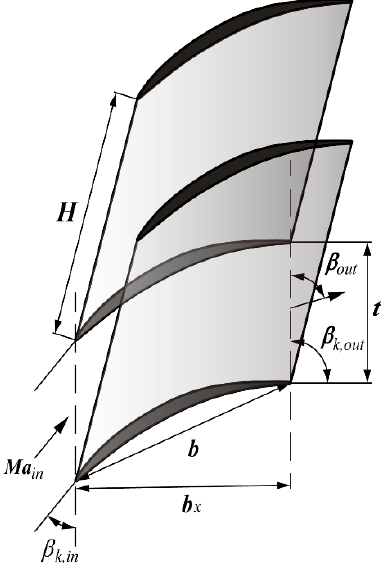
Figure 1. Schematic of cascade.